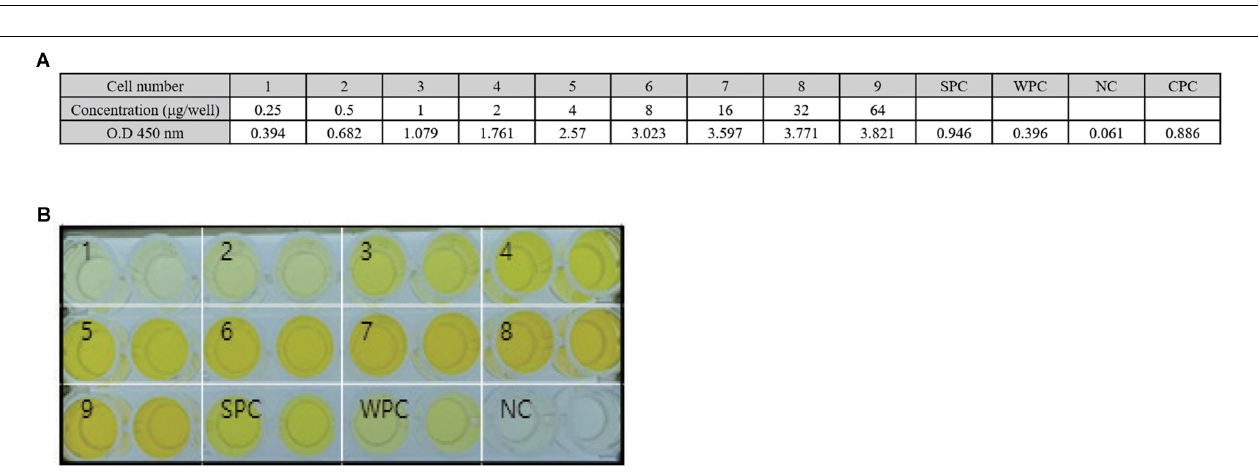
FIGURE 4 | E2 fusion protein produced in Nicotiana benthamiana is recognized by an antibody to E2 of classical swine fever virus. (A) Quantification of the reactivity of plant-produced E2 fusion protein (ppE2) with anti-E2 antibody. Purified ppE2 was serially diluted and analyzed by ELISA, along with a strong protein control (SPC) and a weak protein control (WPC), with measurement of signal intensity at A 450 . (B) Visualization of the reactivity of ppE2 with anti-CSFV E2 antibody. Purified ppE2 was added to wells of an anti-CSFV E2 antibody-coated plate, and the reactivity was visualized using 3,3 (cid:48) ,5,5 (cid:48) -Tetramethylbenzidine as substrate. Lanes 1–9, purified ppE2; SPC, strong positive control; WPC, weak positive control; NC negative